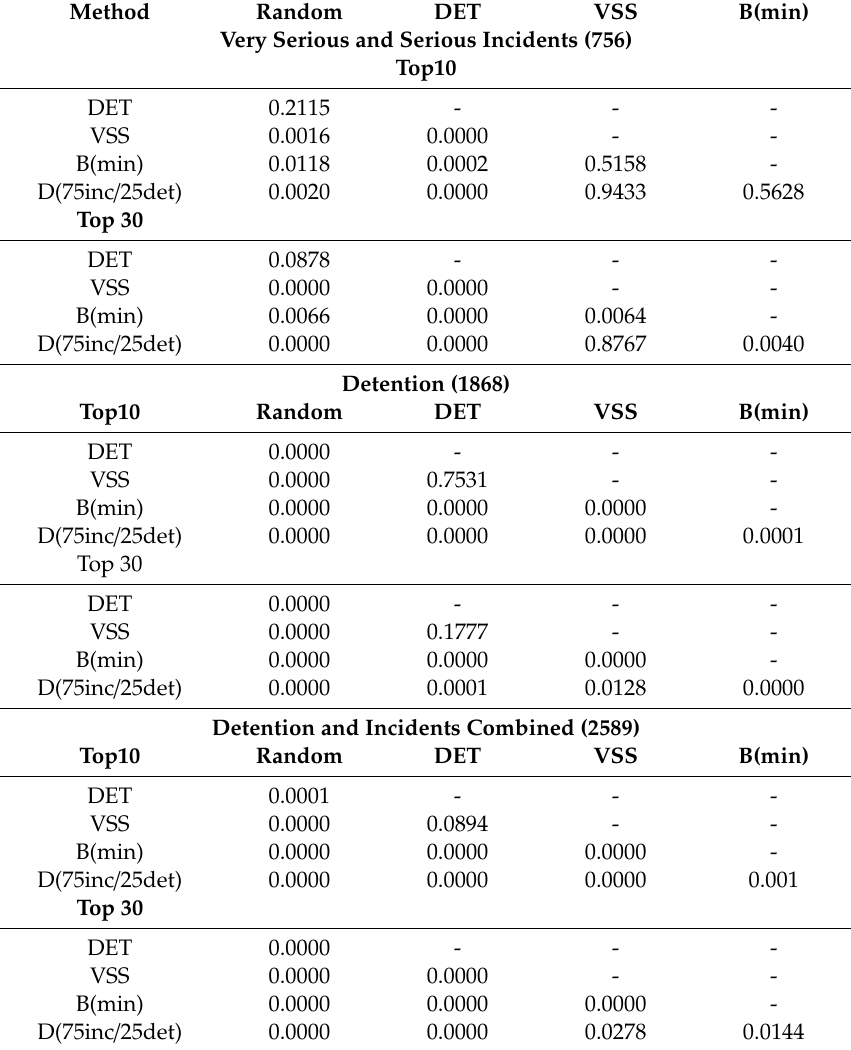
Table A2. P values of the Satterthwaite Welch t-test.